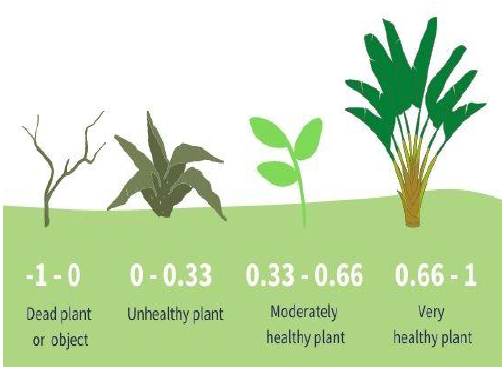
Figure 1. Plant groups with values in the range [-1,